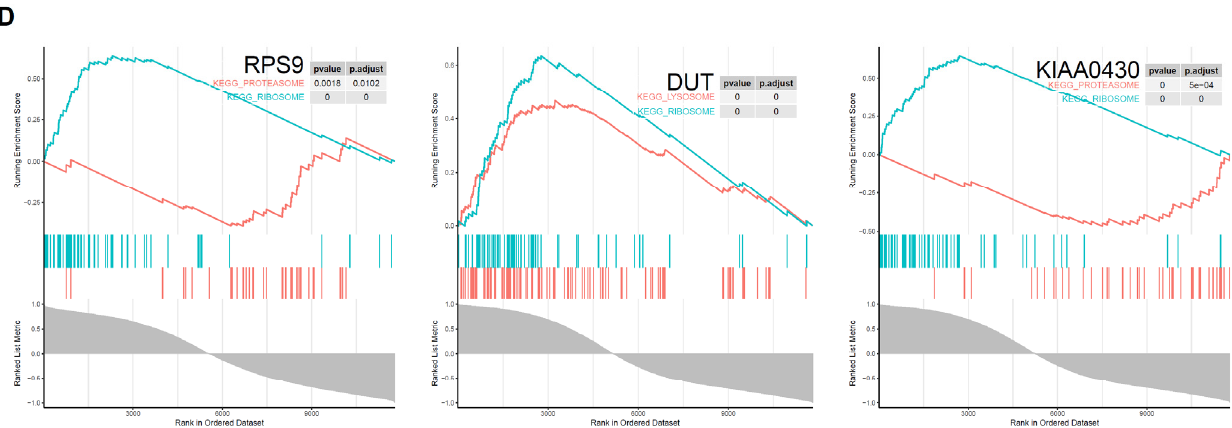
Figure 4. Hub gene selection and verification. ( A ) Venn plot for gene screening. Intersections between modules and hub genes calculated by CytoHubba were selected. ( B ) Univariate analysis of screened genes. RPS9 (OR (Odd rated) = 3.26 (95% CI 1.07–10.97)), DUT (OR = 6.23 (95% CI 1.32–38.25)), and KIAA0430 (OR = 4.35 (95% CI 1.30–15.85)) genes showed significant benefits for fertility. ( C ) Verification of correlation among hub genes and M1 and M2 macrophages. ( D ) Pathway validation of hub genes in macrophage polarization. RPS9 related genes shows an enrichment in ribosomal and proteasomal pathway ( p adjust = 0 and 0.0102), DUT in ribosomal and lysosome pathway ( p adjust = 0 and 0), and ribosomal and proteasomal ( p adjust = 0 and 5 × 10 − 4 ).